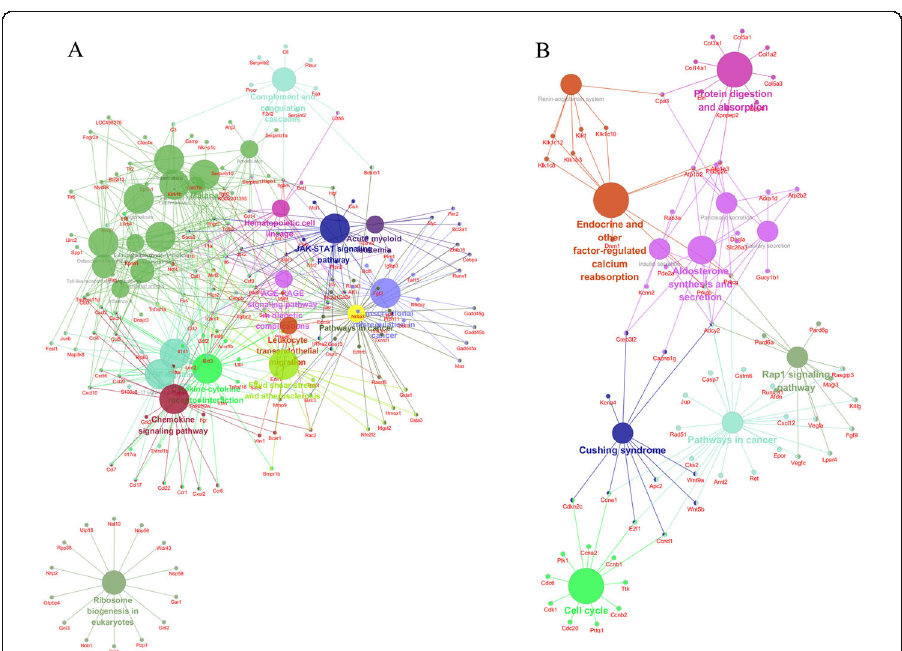
Fig. 5 Kyoto Encyclopedia of Genes and Genomes (KEGG) pathway analysis of aberrantly expressed genes performed using ClueGO. a KEGG pathway classification of upregulated genes. b KEGG pathway classification of downregulated